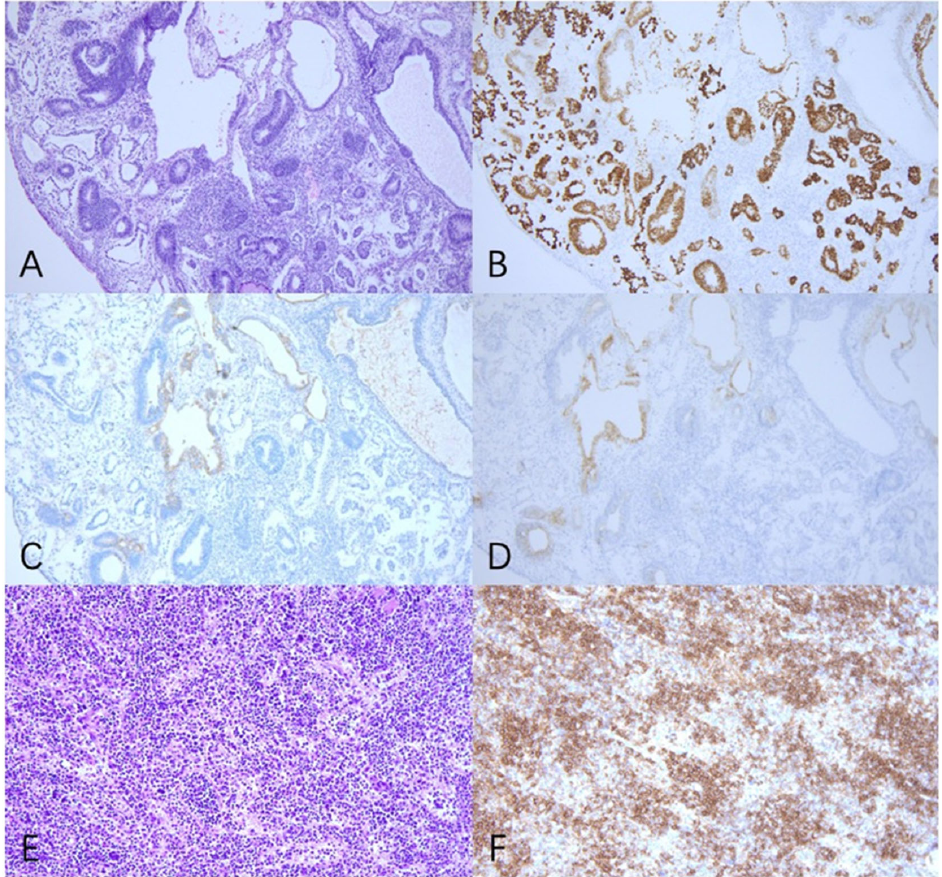
Figure 2. Pathology revealed that the tumor in the abdomen and pelvic cavity was IMT with YST components ( A – D ), and the spleen was B ‐ cell lymphoblastic leukemia/lymphoma ( E , F ). ( A ) Primitive neural tube and yolk sac tumor cell (H&E 100×). ( B ) Positivity for SALL4 immunostaining in tumor cells (100×). ( C ) Positivity for AFP immunostaining in tumor cells (100×). ( D ) Positivity for GPC3 immunostaining in tumor cells (100×). ( E ) The spleen (H&E 200×). ( F ) Positivity for CD20 immunostaining in tumor cells (200×).